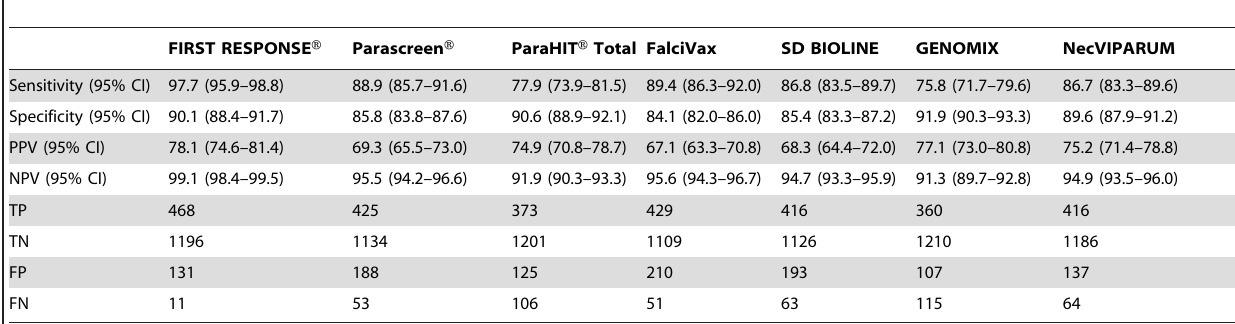
Table 1. Evaluation of P. falciparum by seven different RDTs against light microscopy as gold standard in four district of Madhya Pradesh, central India.